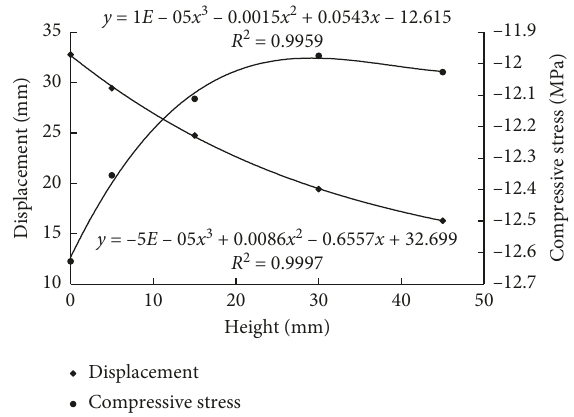
Figure 9: SU-OT height-displacement/compressive stress plot.